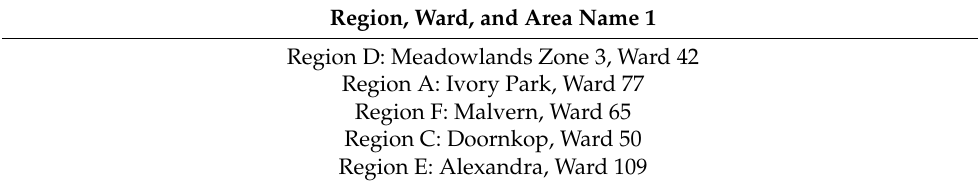
Table 1. List of areas where schools were